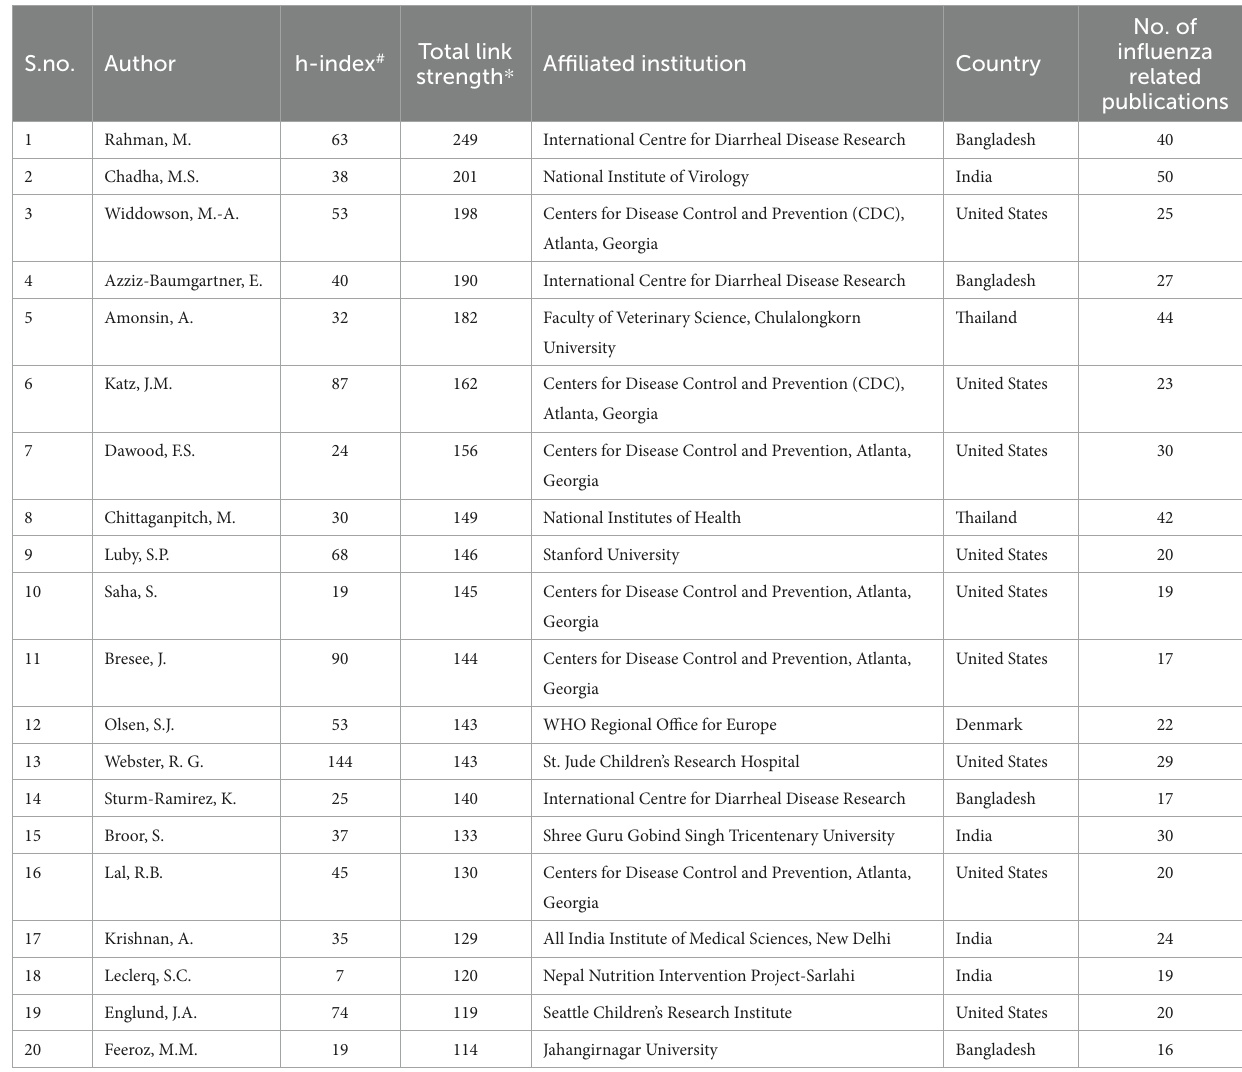
TABLE 5 List of top 20 authors contributing to South East Asian Region related influenza research between 2000 and 2021, based on their total link strength.